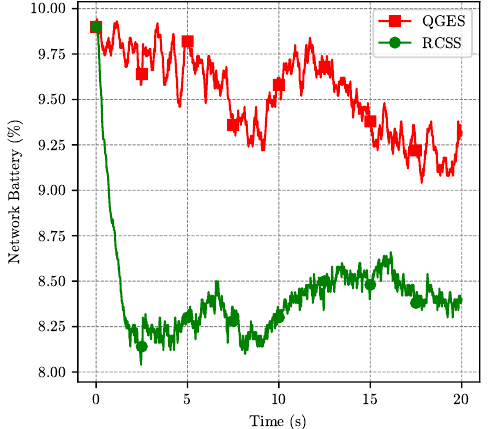
Figure 12. The electric quantity of the system with two